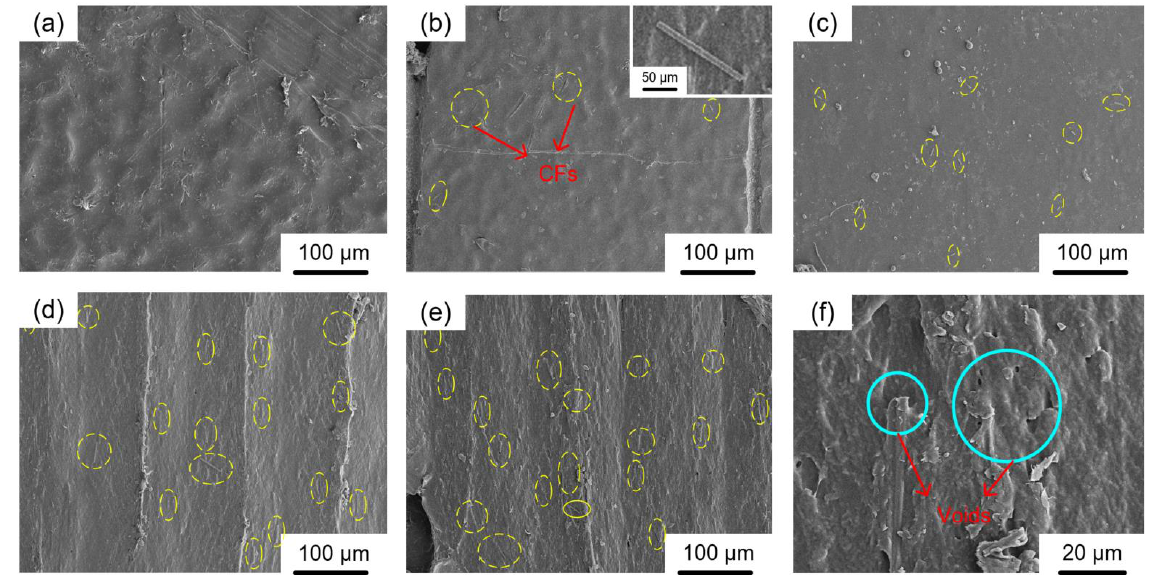
Figure 5. SEM images on cross-sections of parts with different CF contents: ( a ) a HDPE part, ( b ) a 2 wt.% CF + HDPE composite, ( c ) a 6 wt.% CF + HDPE composite, ( d ) a 10 wt.% CF + HDPE composite, ( e ) 14 wt.% CF + HDPE part, and ( f ) a 14 wt.% CF + HDPE part with magnified bonding area.